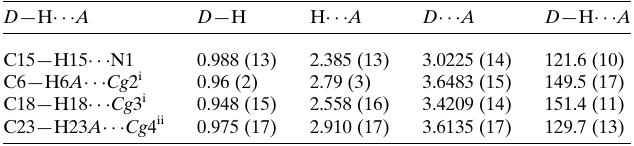
Table 1 Hydrogen-bond geometry (A˚ , (cid:2)